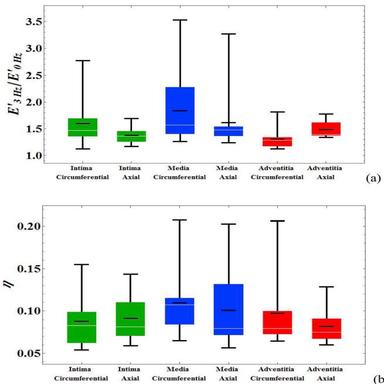
Statistical analysis of the storage modulus and loss tangent for intima, media and adventitia in both directions; maximum, minimum, 1st quartile, 3rd quartile, average (black horizontal line inside the box) and median (white horizonal line in the box) are reported. (a) Storage modulus ratio E E 3 0 Hz Hz / ; (b) loss tangent at 3 Hz loading frequency.